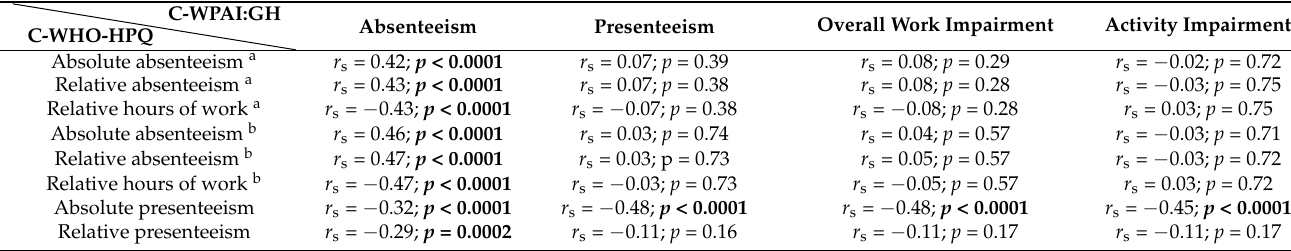
Table 4. Associations between the C-WHO-HPQ and C-WPAI:GH.